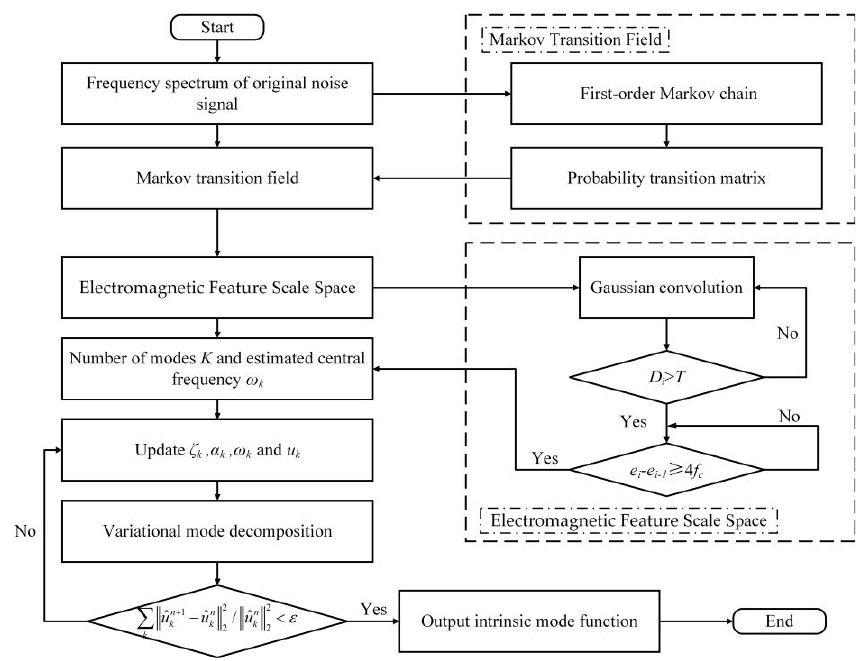
Figure 3. The flowchart of ASSME .